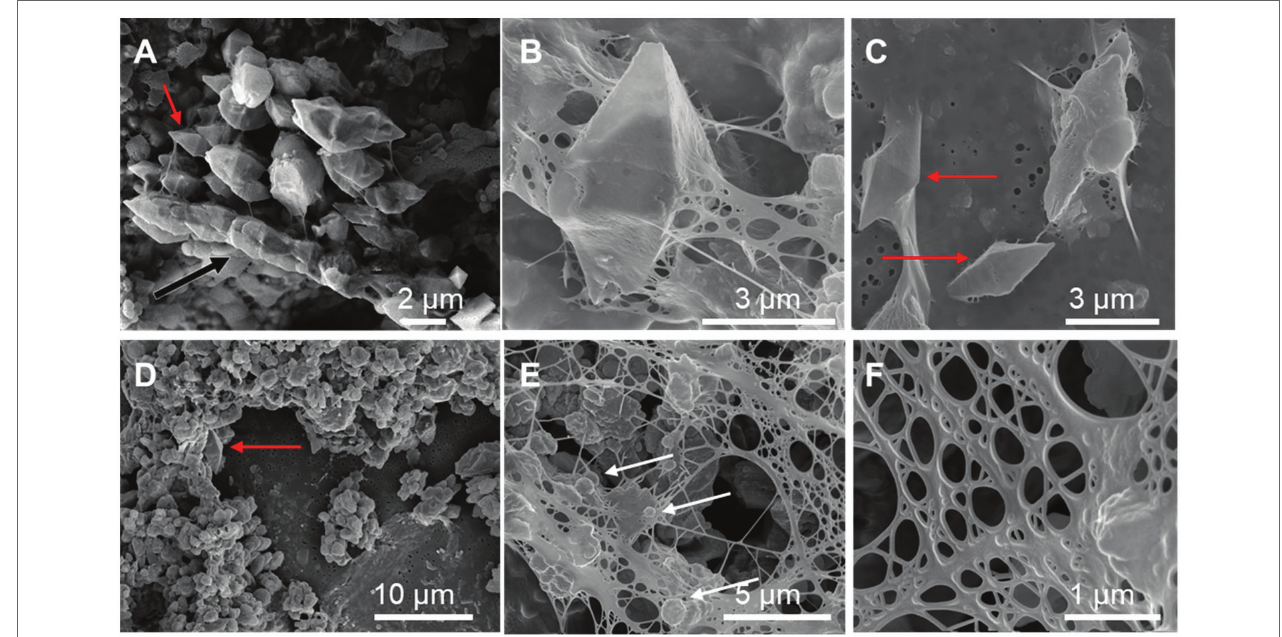
FIGURE 2 | Scanning electron microscopy images of sulfur particles associated with EPS in Sulfurovum -dominated streamer biofilms. Samples include (A) PC1647 and (B–F) PC1718. Red arrows point to bipyramidal S(0) crystals and white arrows point to S(0) spheroids. (A) shows an example of a chain formed by fused bipyramidal S(0) crystals (black